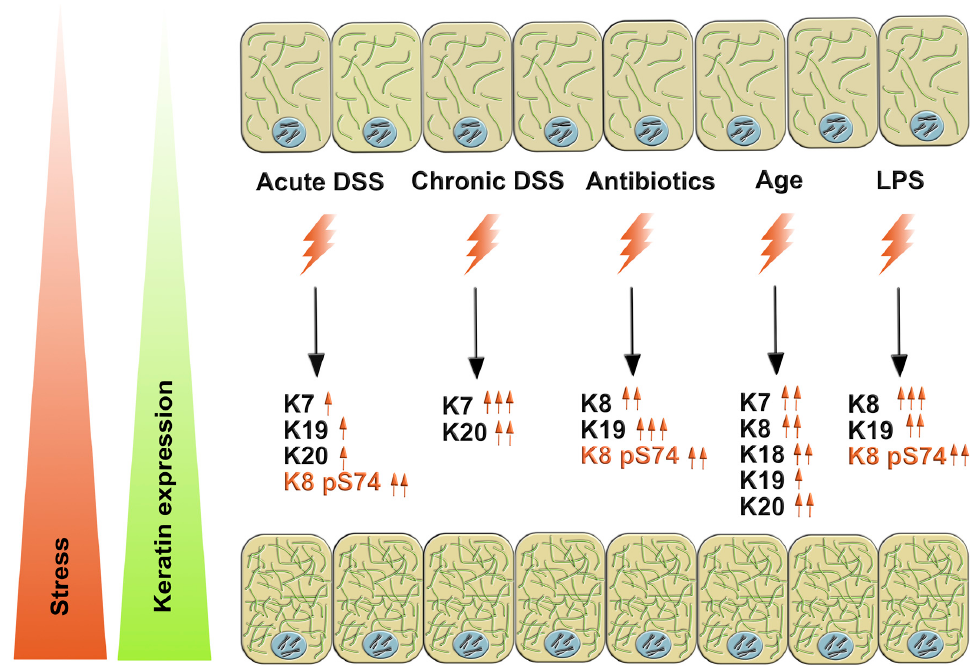
Figure 7. Intestinal keratins K7, K8, K18, K19 and K20 are stress-responsive proteins, which display a pair-wise and context-specific upregulation in response to stress. During acute and chronic DSS-stress, the K7–K20 pair is the predominantly overexpressed keratin pair. During murine antibiotic-treatment and in vitro LPS-stress, the keratin pair K8–K19 is overexpressed. During aging, all colonic keratins are upregulated, but most robustly K7, K8, K18 and K20.